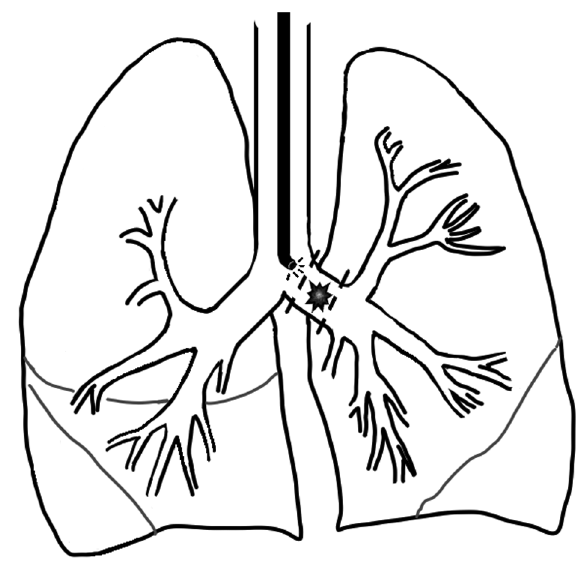
Fig. 2 Endoscopic appearance of the endoluminal lesion in the left main bronchus, obliterating almost all the bronchial lumen. Fig. 3 Schematic drawing of the surgical